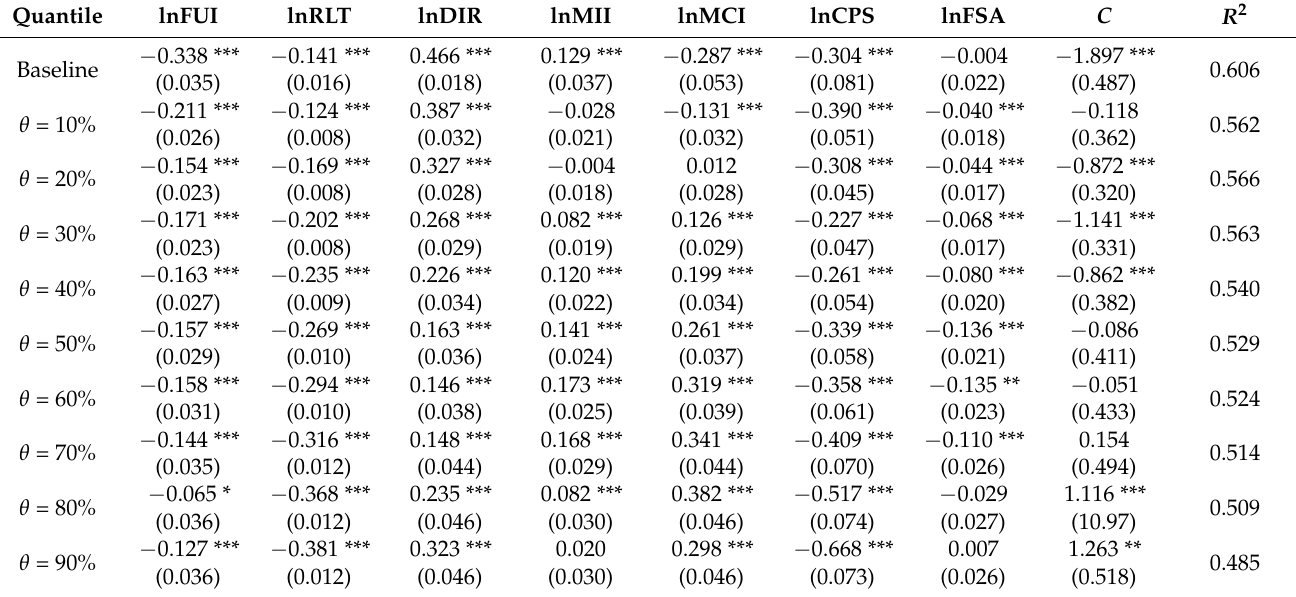
Table 4. Estimation results of the QRM for the impact of FUI on